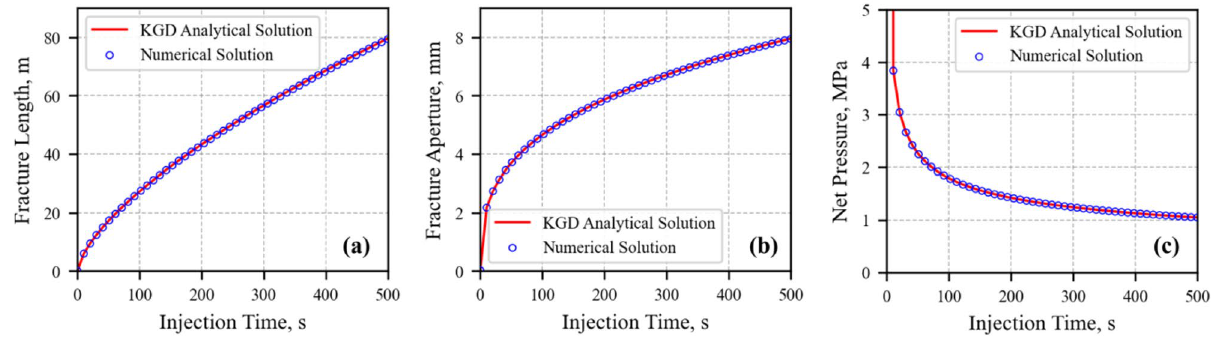
Fig. 5 Simulated fracture geometry during different injection time spans using the KGD model and the model of this study: a fracture length; b fracture aperture; c net pressure